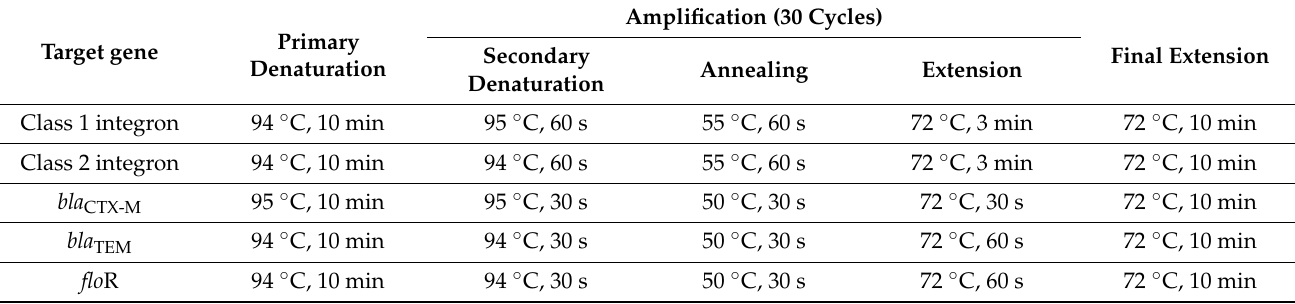
Table 2. PCR amplification and DNA